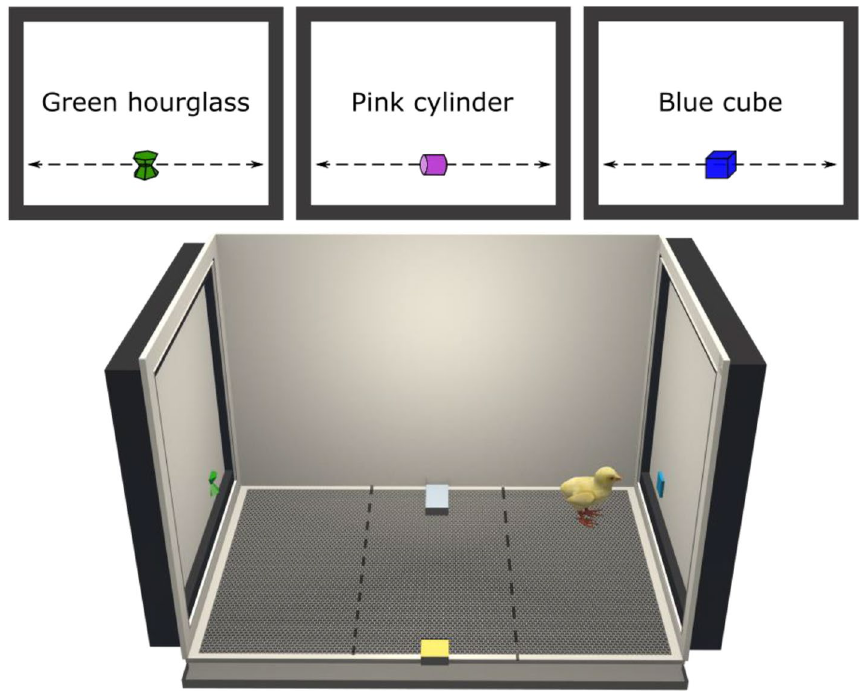
Figure 5. Three-dimensional representation of the apparatus and stimuli used in this study (created with Blender 2.8). The stimuli were moving horizontally alongside the screens to attract the attention of the animals. The filial preference of a chick was revealed by its choice to remain near the stimuli displayed. The dashed lines show the delimitation of the virtual zones used to assess the preference of the animal. The time spent near the stimuli was monitored to calculate a Preference for the imprinting